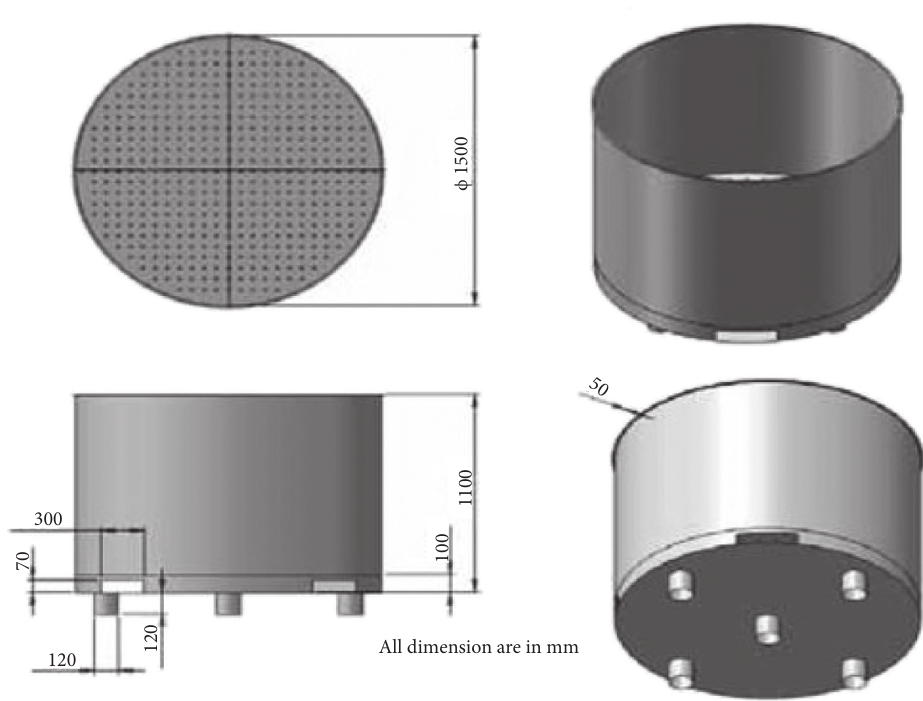
Figure 6: Charcoal